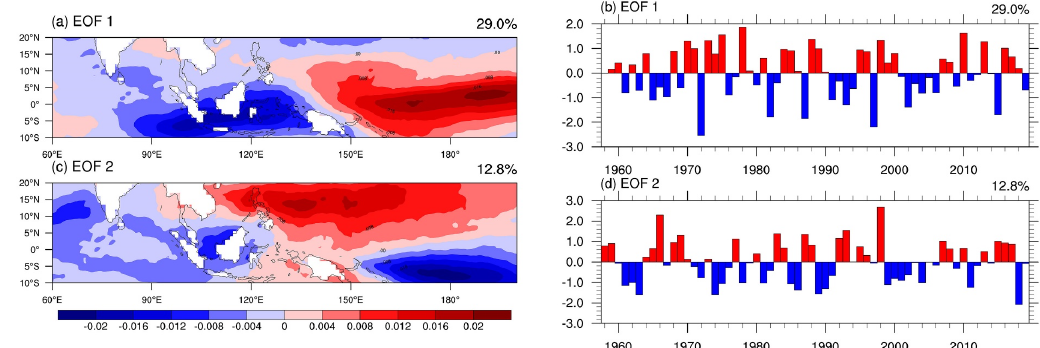
Figure 12. ( a , b ) The EOF1 and EOF2 of the detrended OLR in the IPWP. ( c , d ) The standardized time series of the PC1 and PC2, respectively.